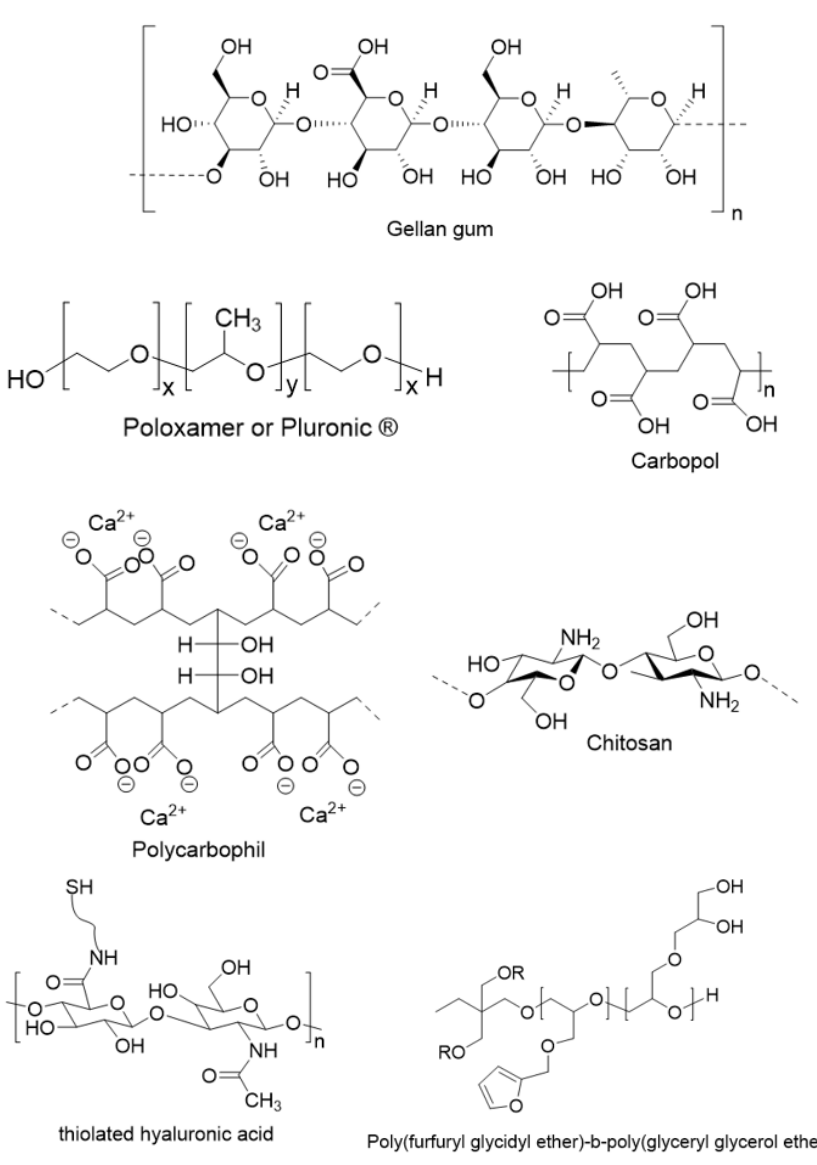
Scheme 2. The molecular structure of most polymers applied for the formation of hydrogels dedicated to gyneacological